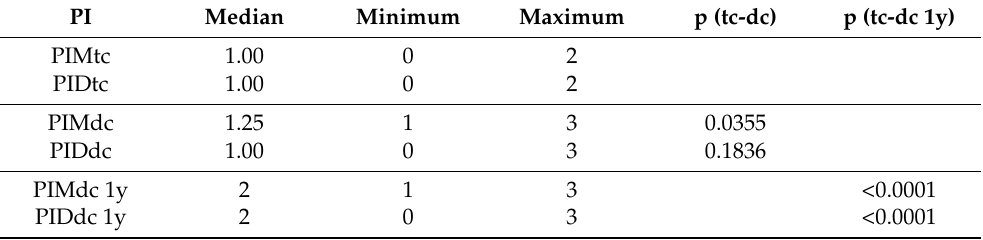
Figure 2. ( a ). Clinical status before treatment. Lack of tooth 14 — tissue deformation, loss of attachment on adjacent tooth 13 and 15. ( b ). Soft tissue status immediately after the temporary crown delivery on the implant in position 14. PES = 6; PIM = 2; PID = 1. ( c ) Soft tissue status immediately after the definitive crown delivery. PES = 6.5; PIM = 2; PID = 1. ( d ) Soft tissue status six months after the definitive crown delivery (one year after implant insertion). PES = 9; PIM = 3; PID = 1. Table 4. Papilla index at relevant stages of study.